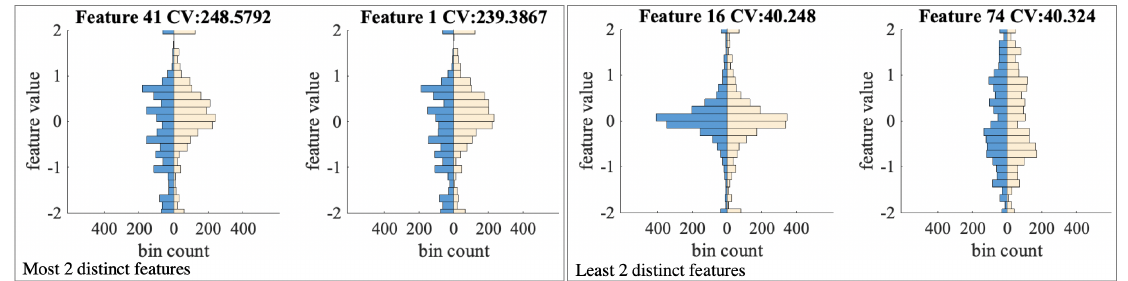
Figure 14. The histogram comparison of those windows with a N-back score above median (in blue) and not (in peach color). Two features resulting in the highest and two with the lowest CV values are